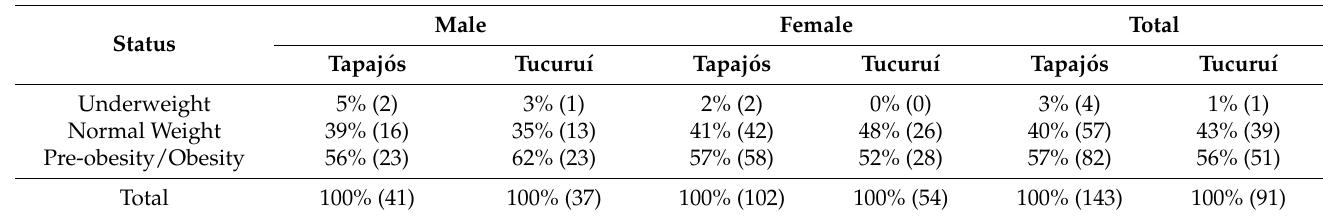
Table 3. The prevalence (and number of participants) according to nutritional status (body mass index, BMI) of the riverine populations in the Tucuru í and Tapaj ó s regions. Note: pre-obesity/obesity classification includes pre-obesity, obesity I, II, and III